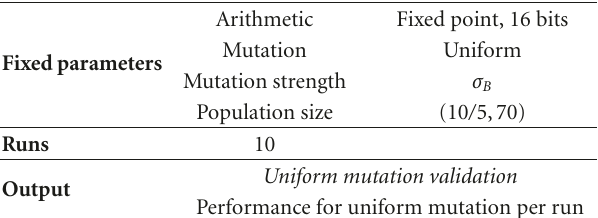
Table 6: Test no. 3 a . Uniform mutation